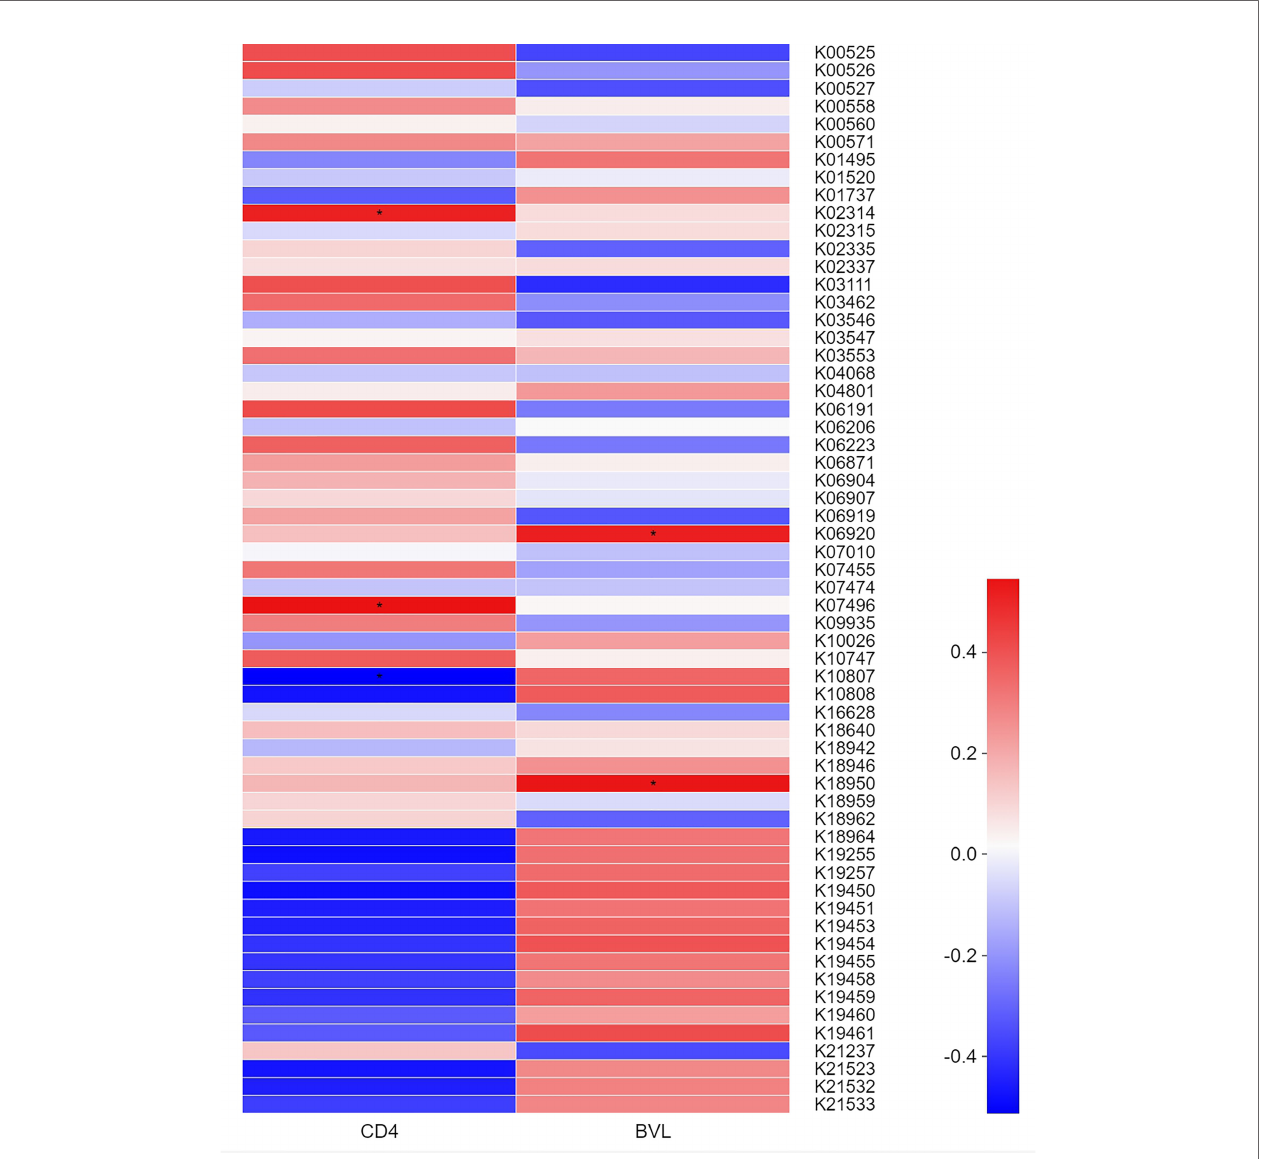
FIGURE 4 | Correlation heatmap showingthe relationshipsbetween the KOs of salivary virome of the top60 abundance andBVL or CD4 counts in the four HIV-positive groups. Colorsrepresent different r values (Spearman correlation coef fi cient):red andblue indicate positive andnegative correlations, respectively. *0.01 <P ≤